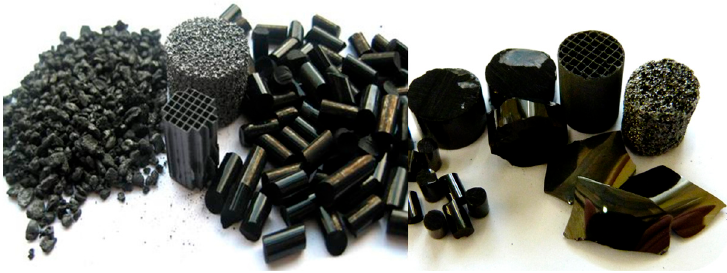
Figure 1. Carbon materials obtained in different formats: grains, powders, pellets, films and coatings on monolith and foam